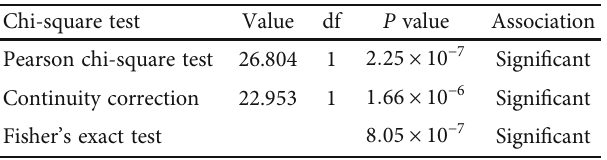
Table 2: Signi fi cance of association between positive fl uid balance and prolonged mechanical ventilation.